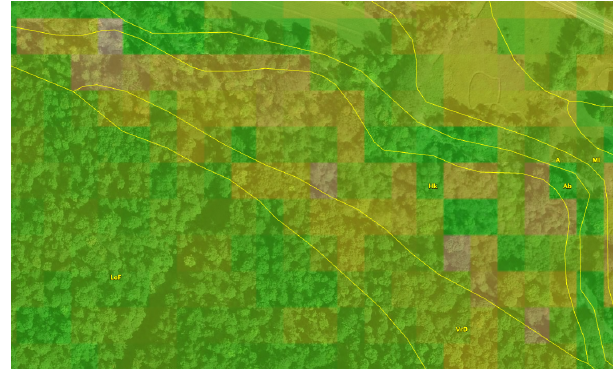
Figure 19. Ground overlay from PSP in the Holly–Papakting map unit and silt (%) at 0–5cm. The centre of the image is at − 76 ◦ 16 (cid:48) 03 (cid:48)(cid:48) E, 42 ◦ 22 (cid:48) 30 (cid:48)(cid:48) N. The disaggregation appears to be random and not related to covariates. The background is from © Google Earth.